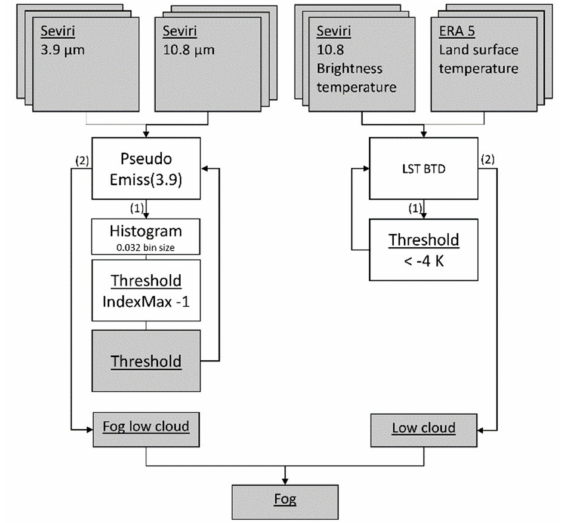
Figure 3. Overview of the Spinning-Enhanced Visible and Infrared Imager (SEVIRI) fog detection methodology. Gray boxes represent data layers and white boxes represent data processing. The numbers on the arrows represent the path on the first and second iteration, respectively. This method was applied per pixel and over a one-month period for each month in the study